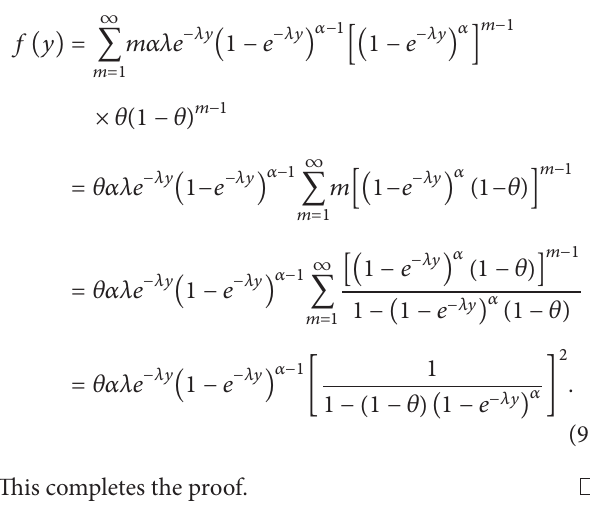
Then, the marginal probability density function of 𝑌 is given